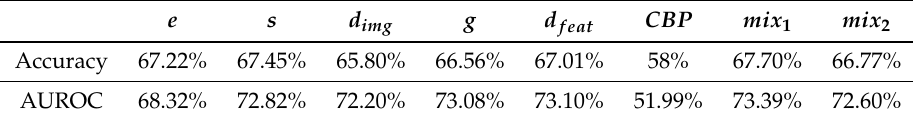
Table 6. Accuracy and AUROC of the uncertainty prediction on the STL test